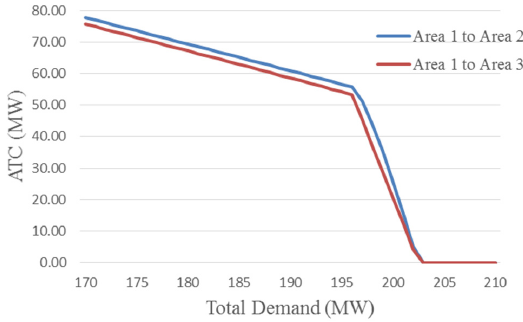
Figure 5. IEEE 30 ‐ bus system with three areas.